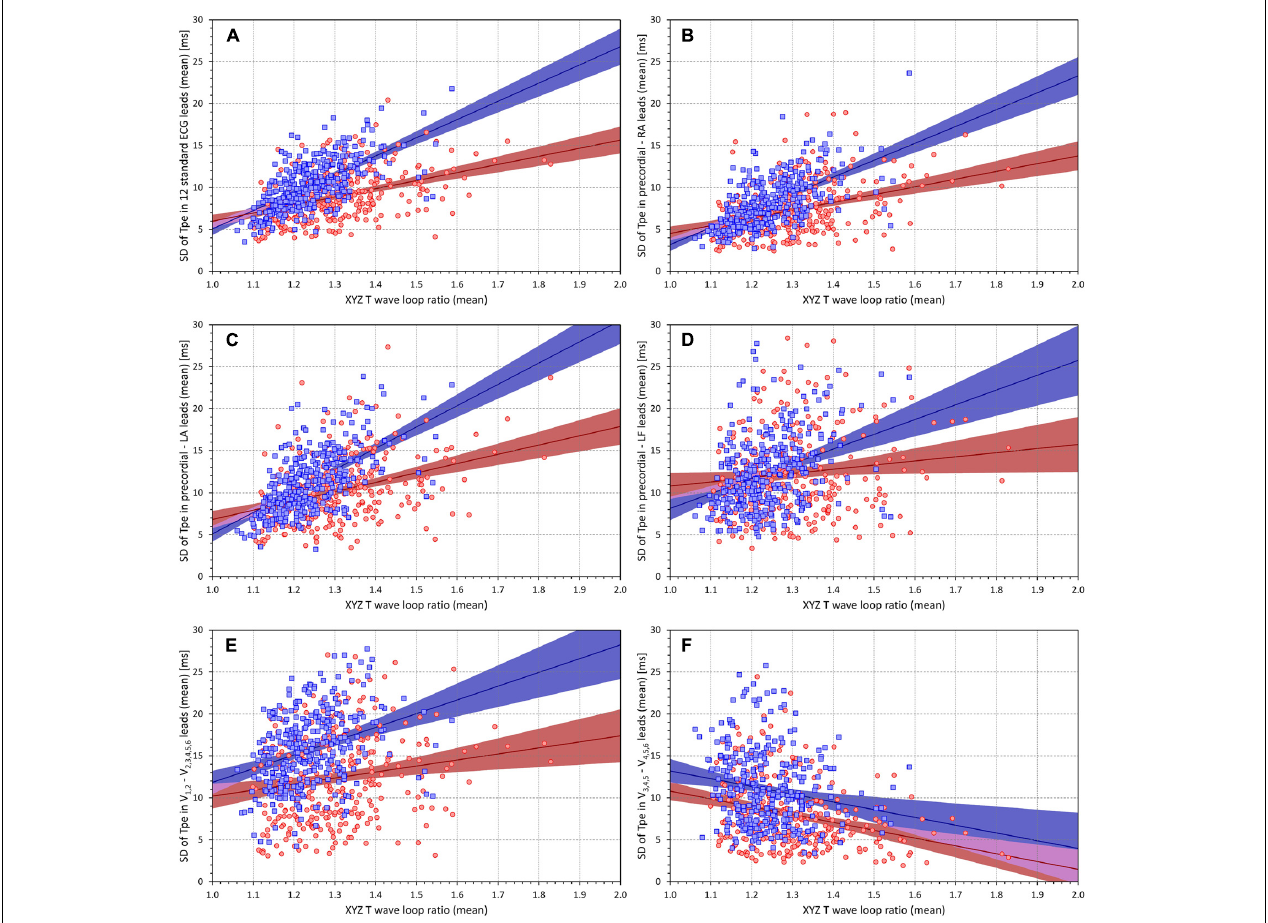
FIGURE 3 | Scatter diagrams between the T wave loop ratios (mean values in individual subjects) and the standard deviations of the Tpe intervals in groups of electrocardiogram (ECG) leads (mean values in individual subjects). Different panels of the figure correspond to different groups of ECG leads—the association of the panels with the lead groups is the same as in Figure 1 . In each panel [please see the labels of vertical axes for the explanation of panels (A–F) ], the red circles and blue squares correspond to female and male subjects, respectively. The solid red and solid blue lines show the linear regressions between the measured standard deviations of Tpe intervals and the T wave loop ratios in female and male subjects, respectively. The red- and blue-shaded areas are the 95% confidence intervals of the regression lines; the violet areas are the overlaps between the confidence intervals of the sex-specific regressions. SD, standard deviation; RA, right arm; LA, left arm; LF, left